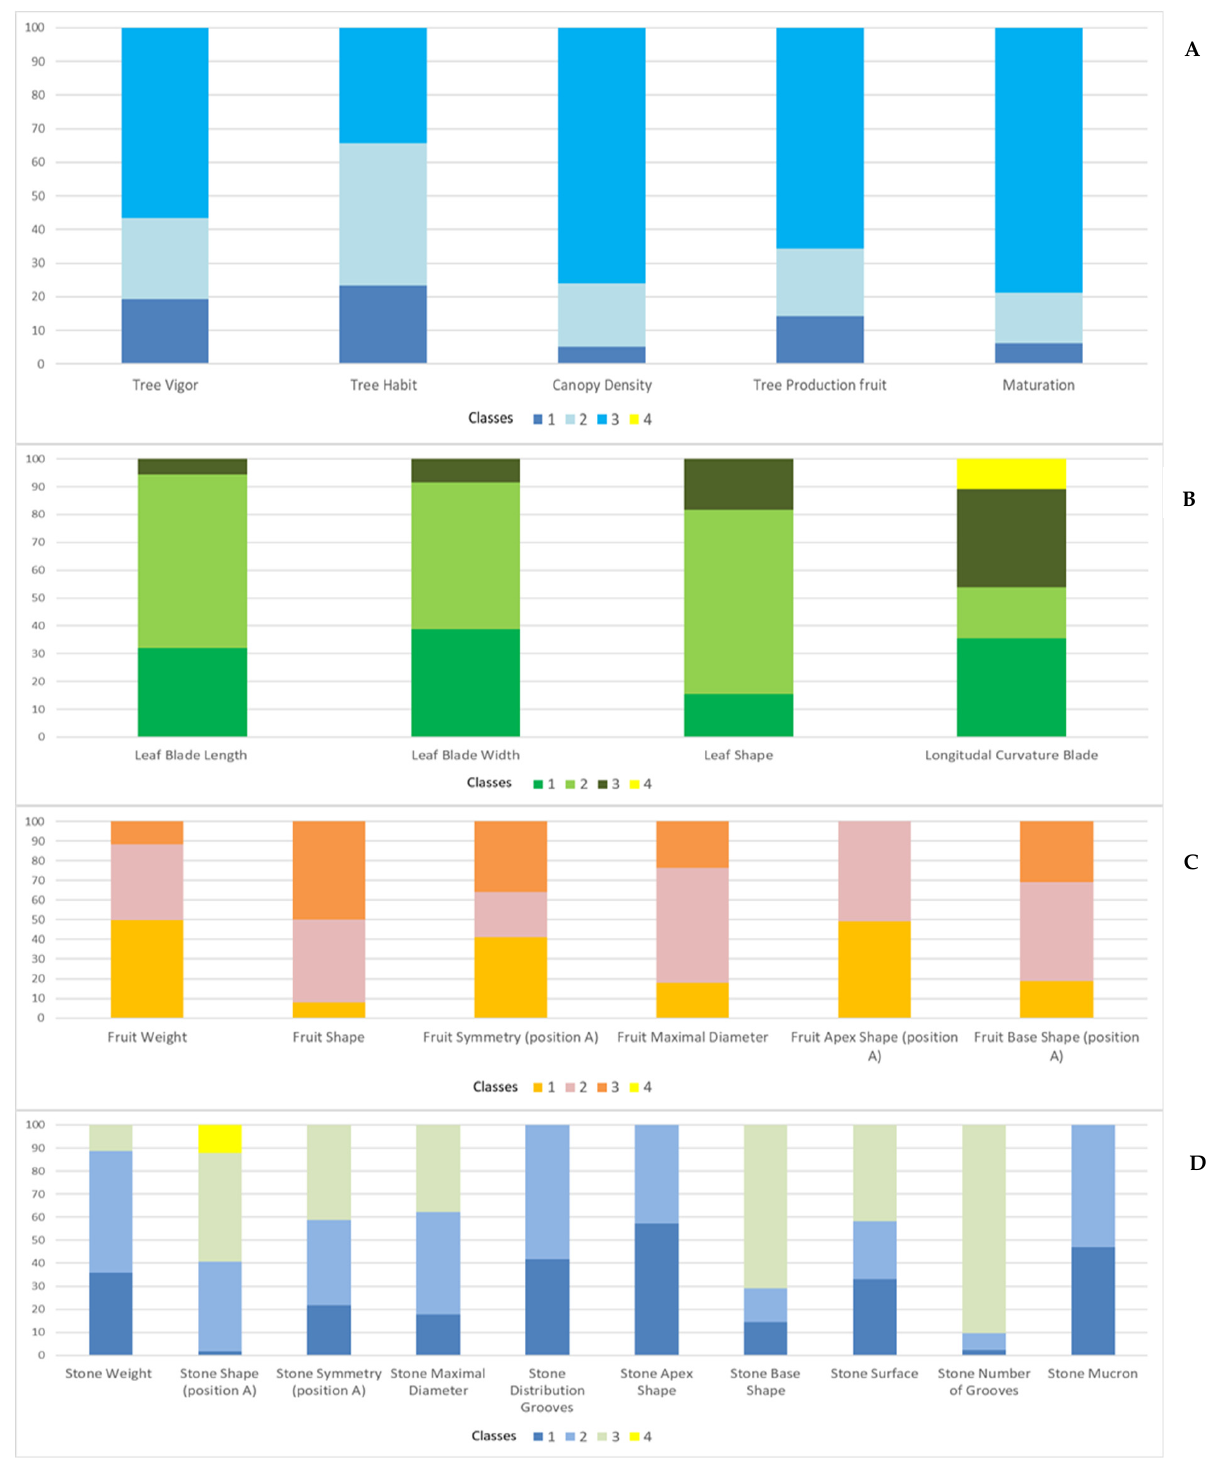
Figure 3. Histograms represent the distribution of the qualitative traits relative to tree habit ( A ), leaf ( B ), fruit ( C ), and stone ( D ) among the analyzed wild olive samples. For each trait (bar), the % of samples falling into each of the four classes considered for descriptors is